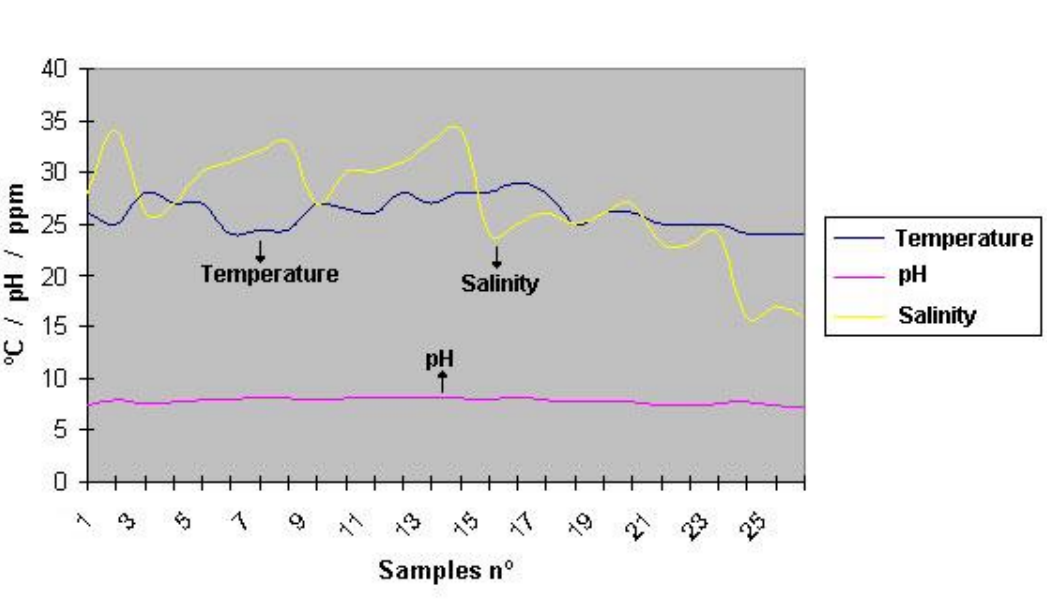
Figure 1. Variation in environmental parameters in estuarine waters of São Vicente’s estuarine system, São Paulo State,